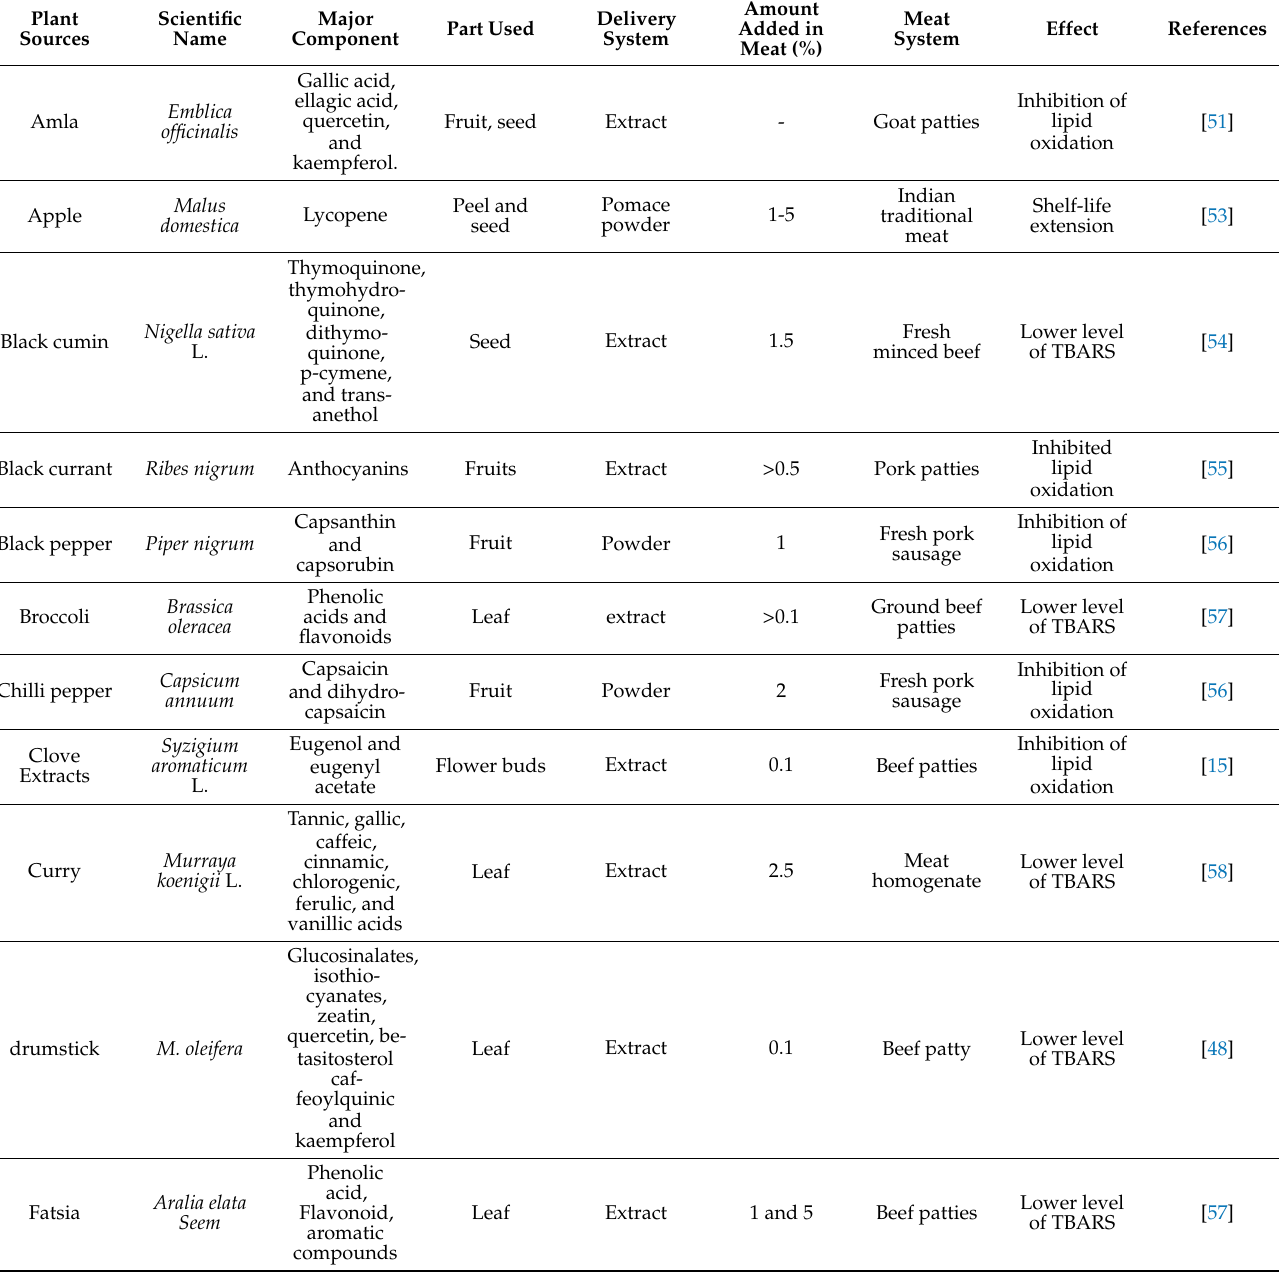
Table 1. Bioactive rich plants as antioxidants preservatives used in comminuted